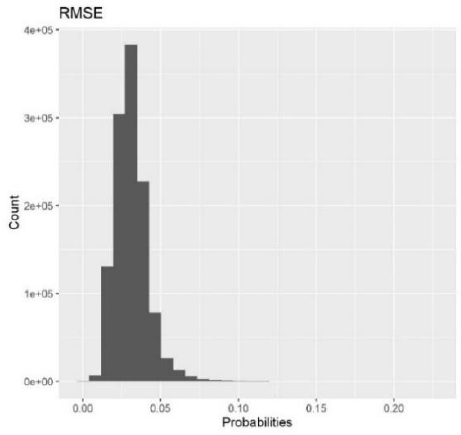
Figure 6: Overall